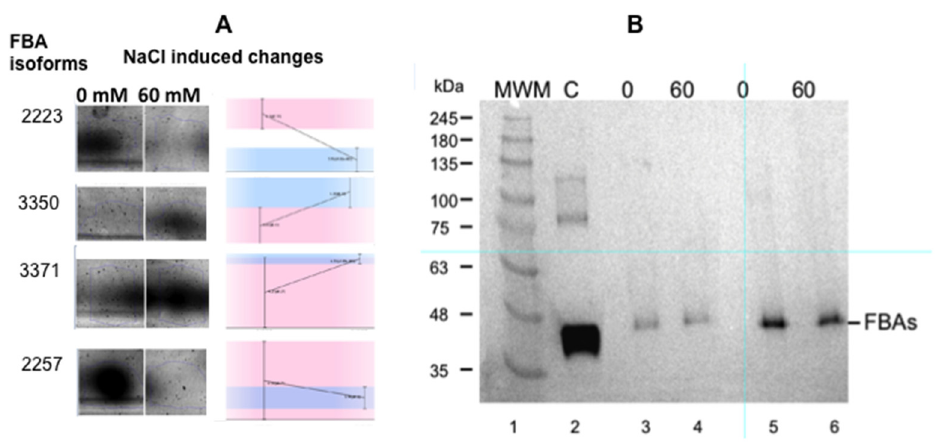
Figure 3. Panel ( A ): Changes in the expression of the different isoenzymes of fructose-1,6 bisphosphate aldolase (FBA) as a consequence of salt stress. (Masto de Montañana in vitro cultured excised roots). The small graphs indicate the changes detected by the gel reader. Panel ( B ): Western blot of the extracts used for proteomics studies (Anticytosolic fructose-1,6 bisphosphate aldolase (FBA8) from Agrisera ® (AS08294) were used at 1: 5000). Lane 1: molecular markers; lane 2: FAB control; lane 3: 0 mM NaCl cultured roots, 60 µg total protein extract; lane 4: 60 mM NaCl cultured roots, 60 µg total protein extract; lane 5: 0 mM NaCl cultured roots, 120 µg total protein extract; lane 6: 60 mM NaCl cultured roots, 120 µg total protein extract.